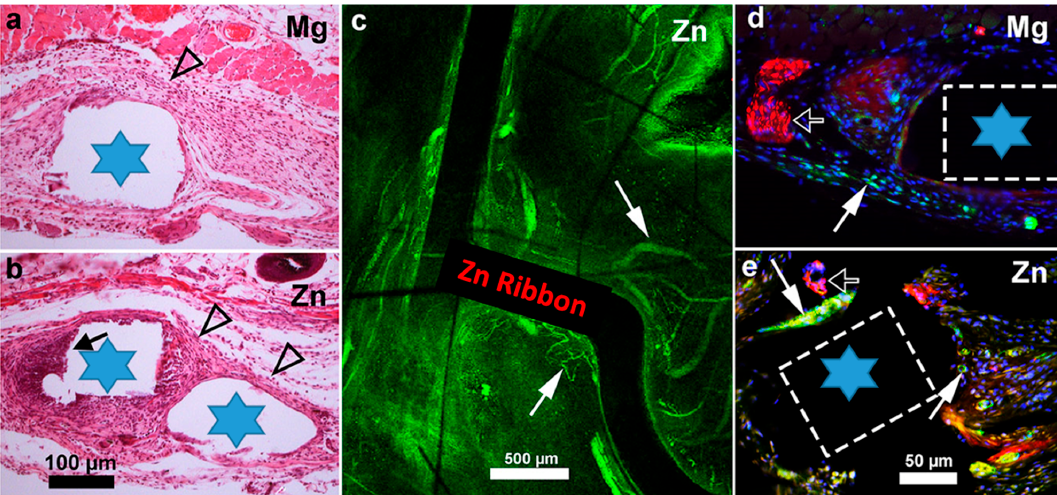
Figure 18. Histology of Mg and Zn ribbon pieces after in vivo implantation: ( a, b ) sections stained with H&E; ( c ) whole mount immunofluorescence; and ( d , e ) sections immunostained for axons (red), blood vessels (green) and nuclei (blue). Little to no capsule ( a, b , open arrowheads) formed around the cavities which had contained ribbon pieces (stars) and there was little inflammation (black arrow, b ). Blood vessels clustered extensively around the stents ( c, d, e , white arrows). Immunostaining confirmed that ( d, e ) both blood vessels (solid white arrows) and nerves (open arrows) were found close to the ribbon pieces (location indicated by white rectangles). (Bar in b applies to a and bar in e applies to d ).